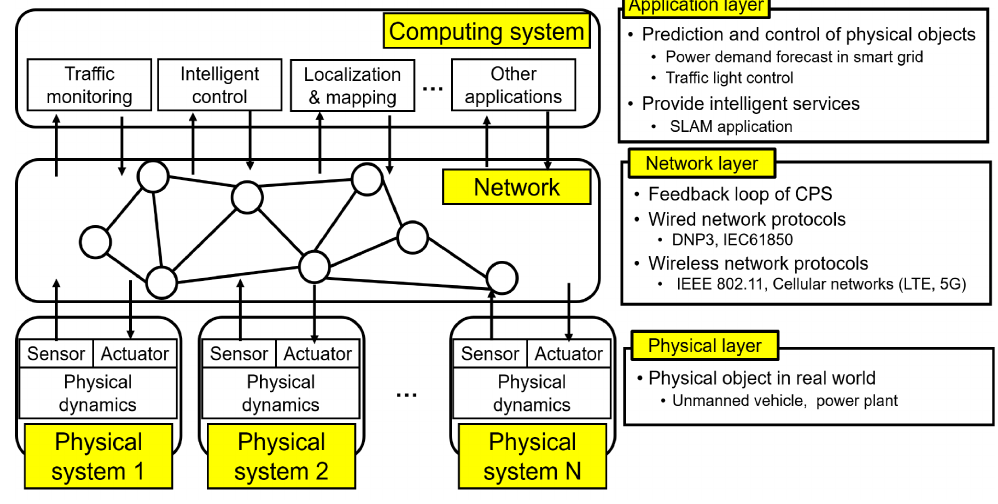
Figure 1. A hierarchical cyber-physical system